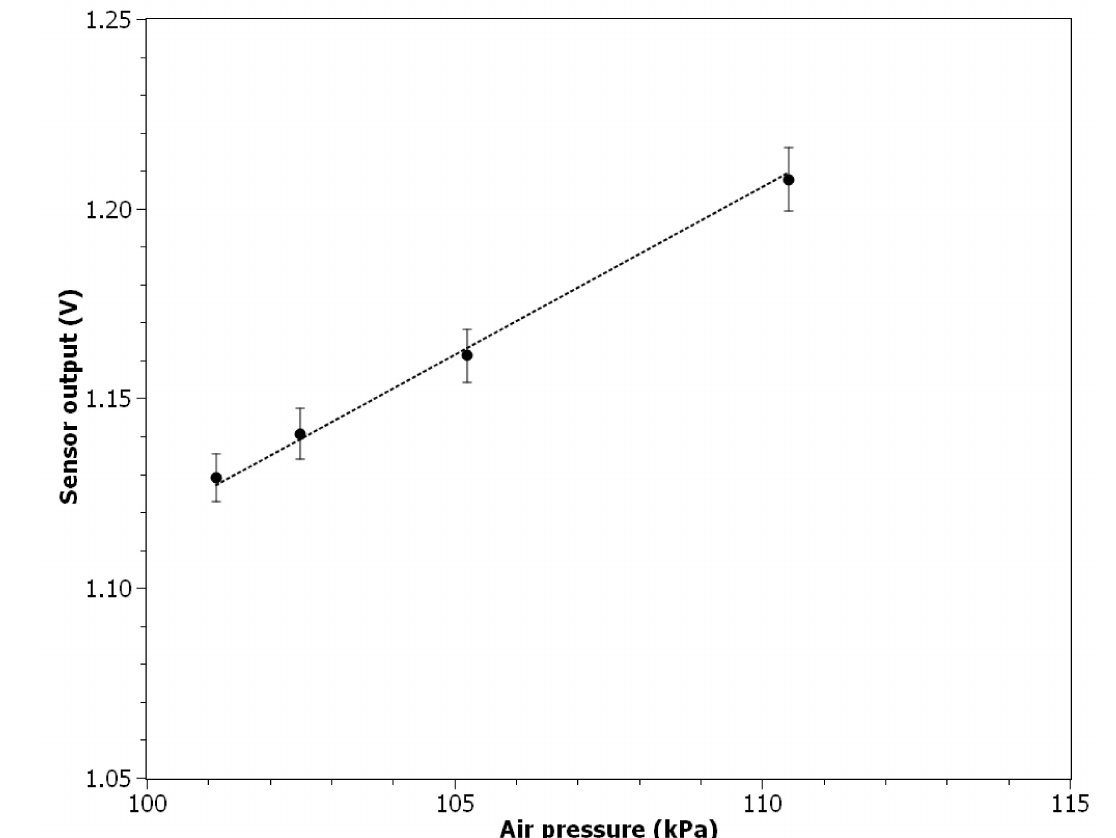
Figure 9. Sensor output signal in response to air pressure change.